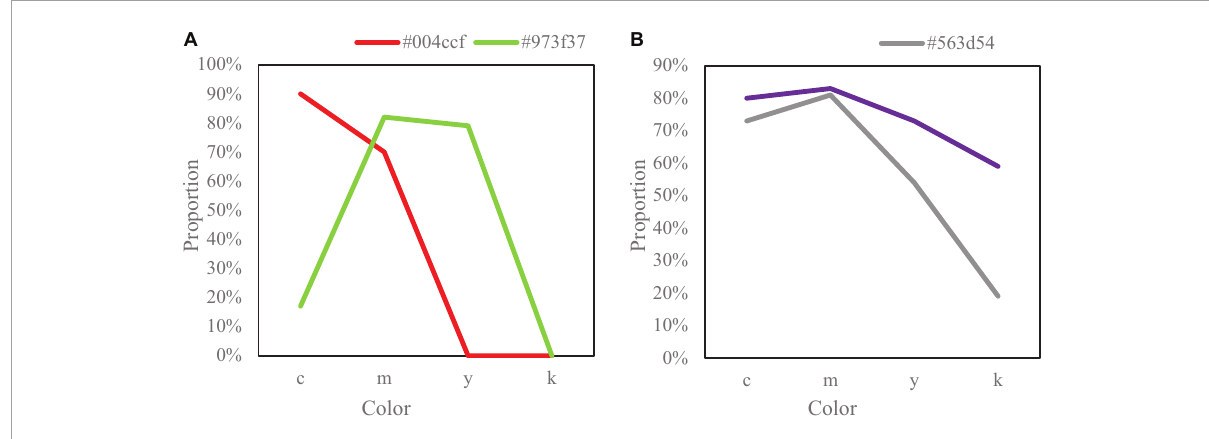
FIGURE8 CMYK of primary colors drawn. (A) Shows CMYK of #004ccf with 90% cyan, 70% magenta (magenta), and zero for the other two colors. (B) Shows CMYK of #563d54 with 73% cyan, 81% magenta (magenta), 54% yellow, and 19% black.